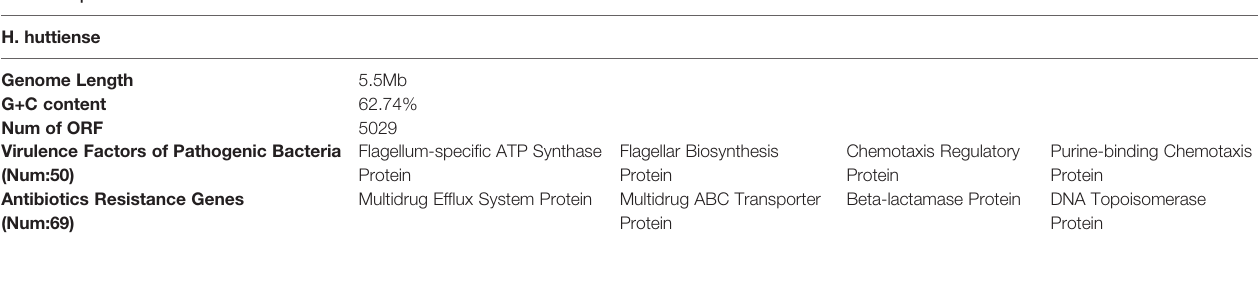
TABLE 2 | Genome characteristics of H. huttiense . H.